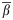
Examples of simulation dynamics.(A) Full equilibrium (FE). (B) Shifting mosaic steady state (SMSS). A total of 10,000 patches were simulated, with the left panel showing the number of infected cells in two of these patches (red and blue lines, left-axis) and the total number of infected cells in the whole metapopulation, summed over all the patches and the blood, but not the reservoir (black line, right-axis; note this is on a Log10 scale). The right panel shows the CTL response, measured as the rate at which CTLs kill infected cells in each of these two patches, which is proportional to the number of CTLs in the patches. (A) Viral infectivity, β¯ = 13 per day, maximum strength of the CTL response, k = 10 per day. (B) β¯ = 8 per day, k = 10 per day. We assumed a high effective migration rate (Me = 2.4 per day). The simulation was initiated with 108 infected cells randomly distributed among the patches and no reservoir. See Table 1 for all other parameters.